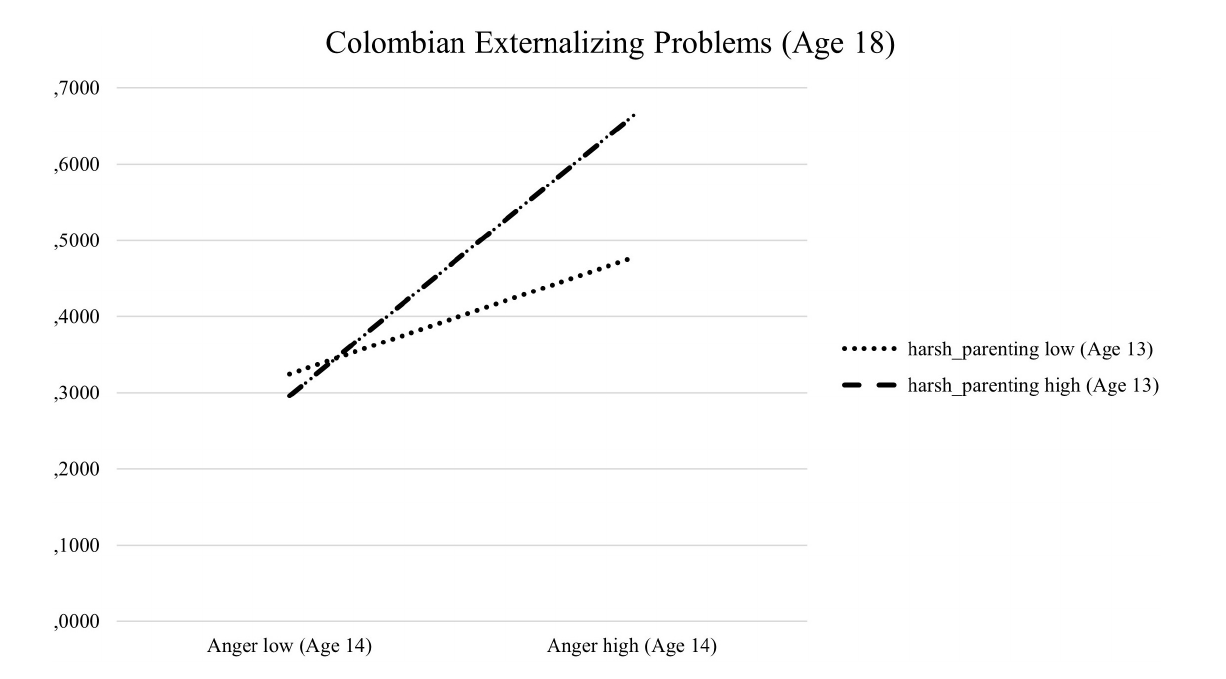
FIGURE2 Interaction effect of T1 harsh parenting and T2 anger in predicting T6 externalizing problems on the Colombian sample.